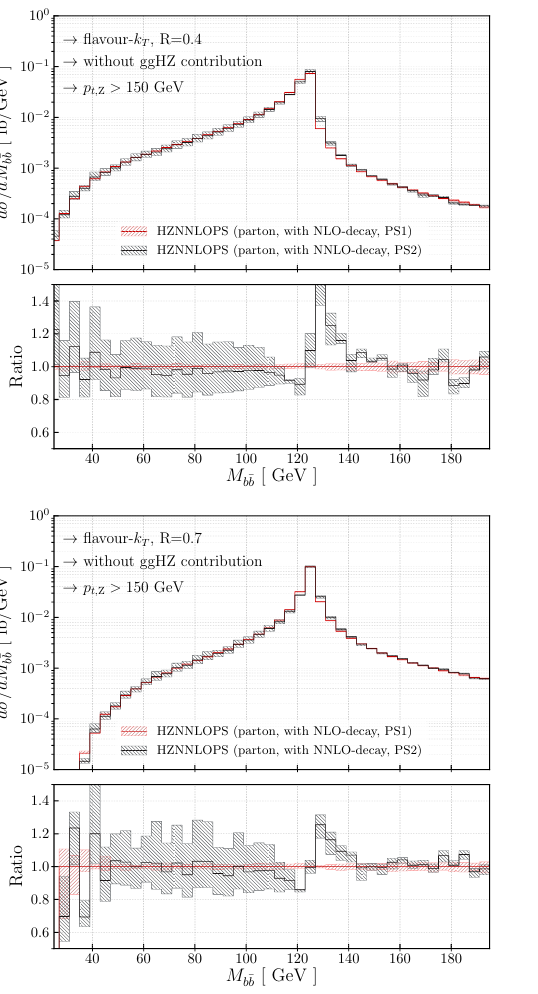
t algorithm with